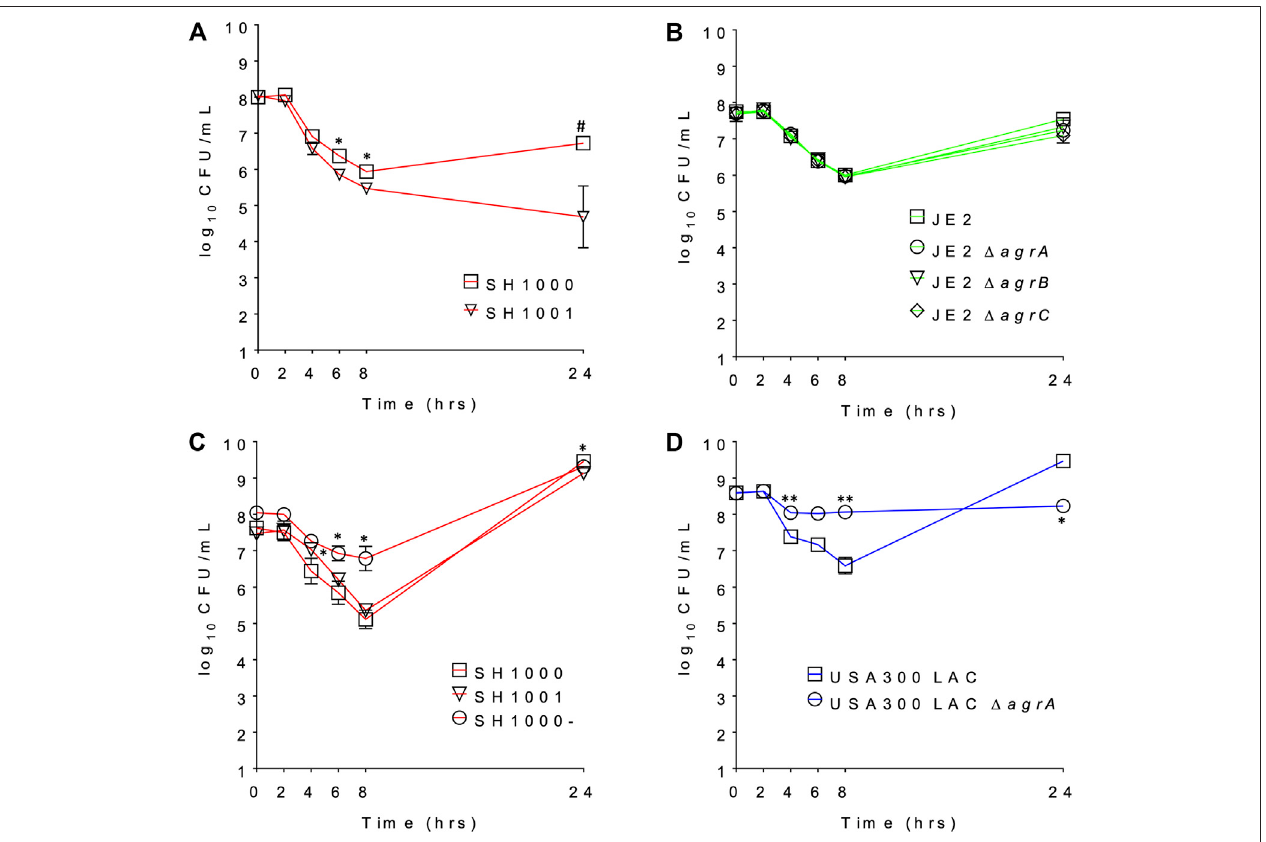
FIGURE 1 | The daptomycin time kill pro fi le of (A) SH1000 and SH1001 pair under lower eration; (B) JE2 transposon series under low aeration; (C) SH1000, SH1001,andSH1000-seriesunderhighereration;and (D) USA300LACpairunderhighaeration. # p < 0.001;**0.001 < p < 0.01;*0.01 < p < 0.05(basedonthepercent survival at each timepoint, relative to the wild-type, Student ’ s t -test, two-tailed, equal variance).